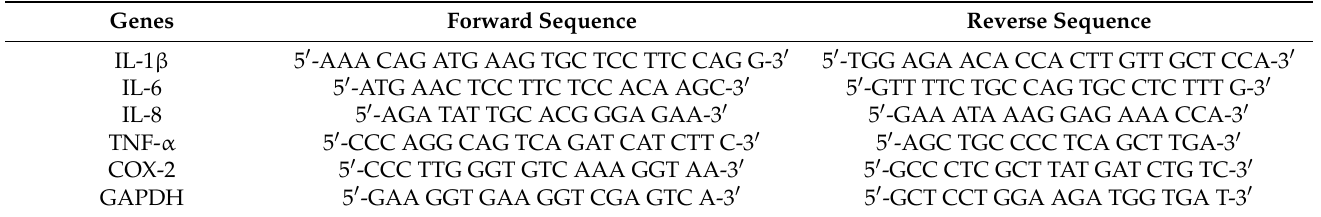
Table 2. Primers for inflammatory cytokines used in quantitative reverse transcriptase-polymerase chain